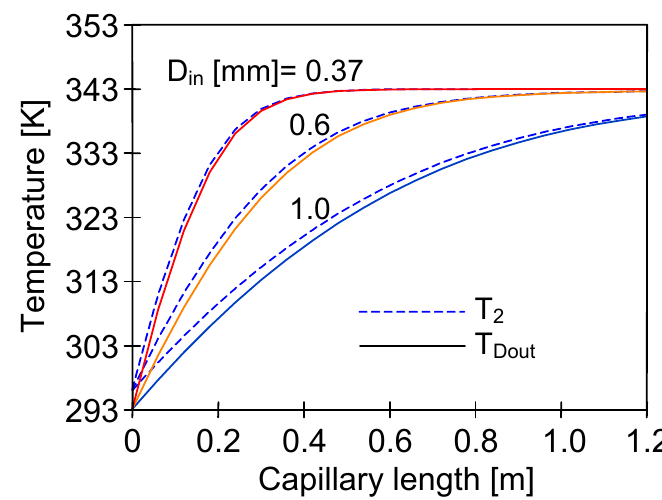
Figure 14. The influence of capillary diameter on the feed outlet temperature. Mode 1. Membrane